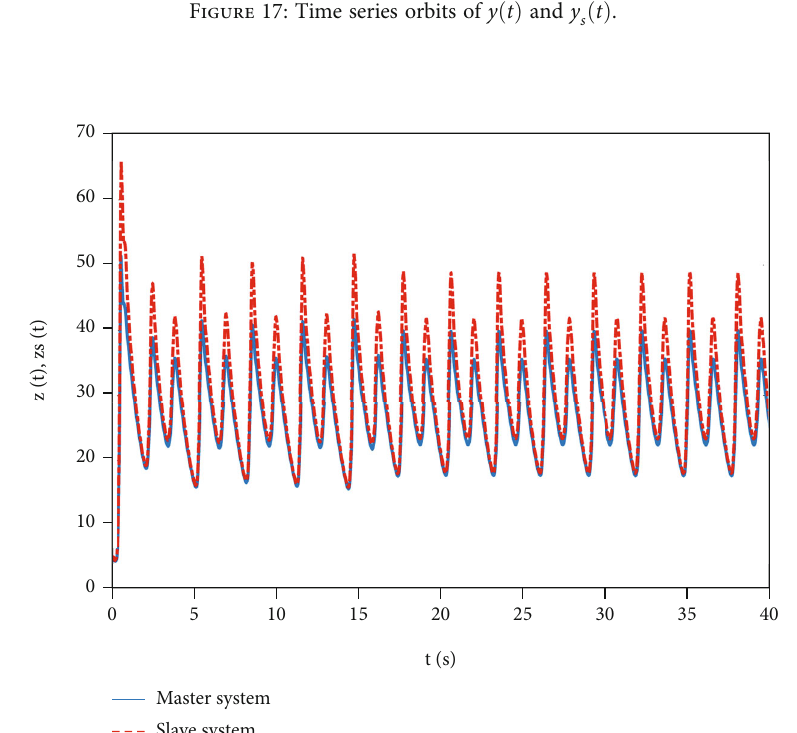
Figure 17: Time series orbits of y ð t Þ and y